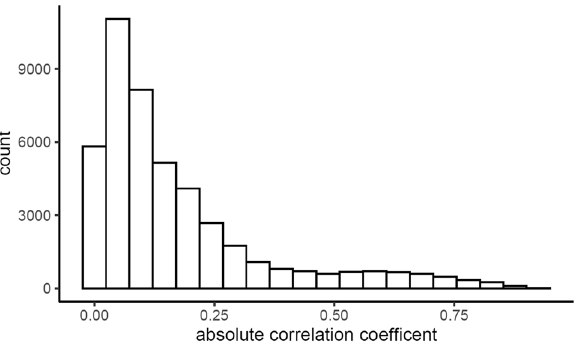
Figure 4. Histogram of absolute correlation coefficients between PyRadiomics and LungTrans.